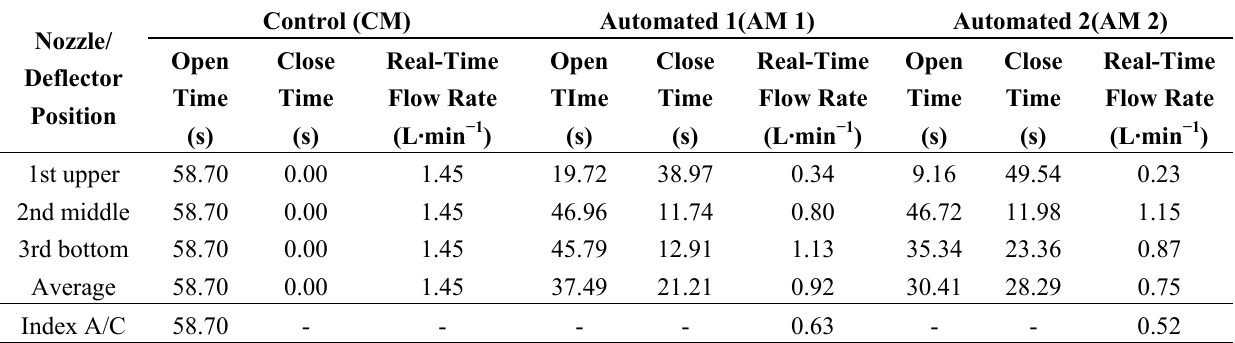
Table 3. Average working time (s) and real-time flow rate (L·min − 1 ) for automated (AM1 and AM2) and control (CM) spray